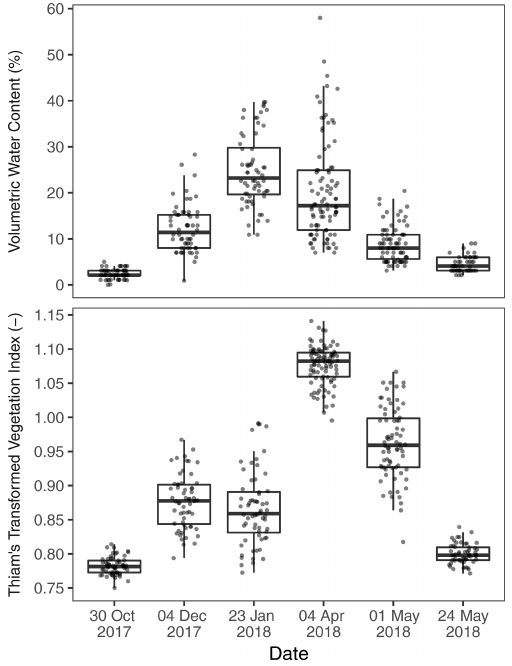
Figure 5. Measured soil moisture and vegetation index of the ground sampling locations from 1m resolution